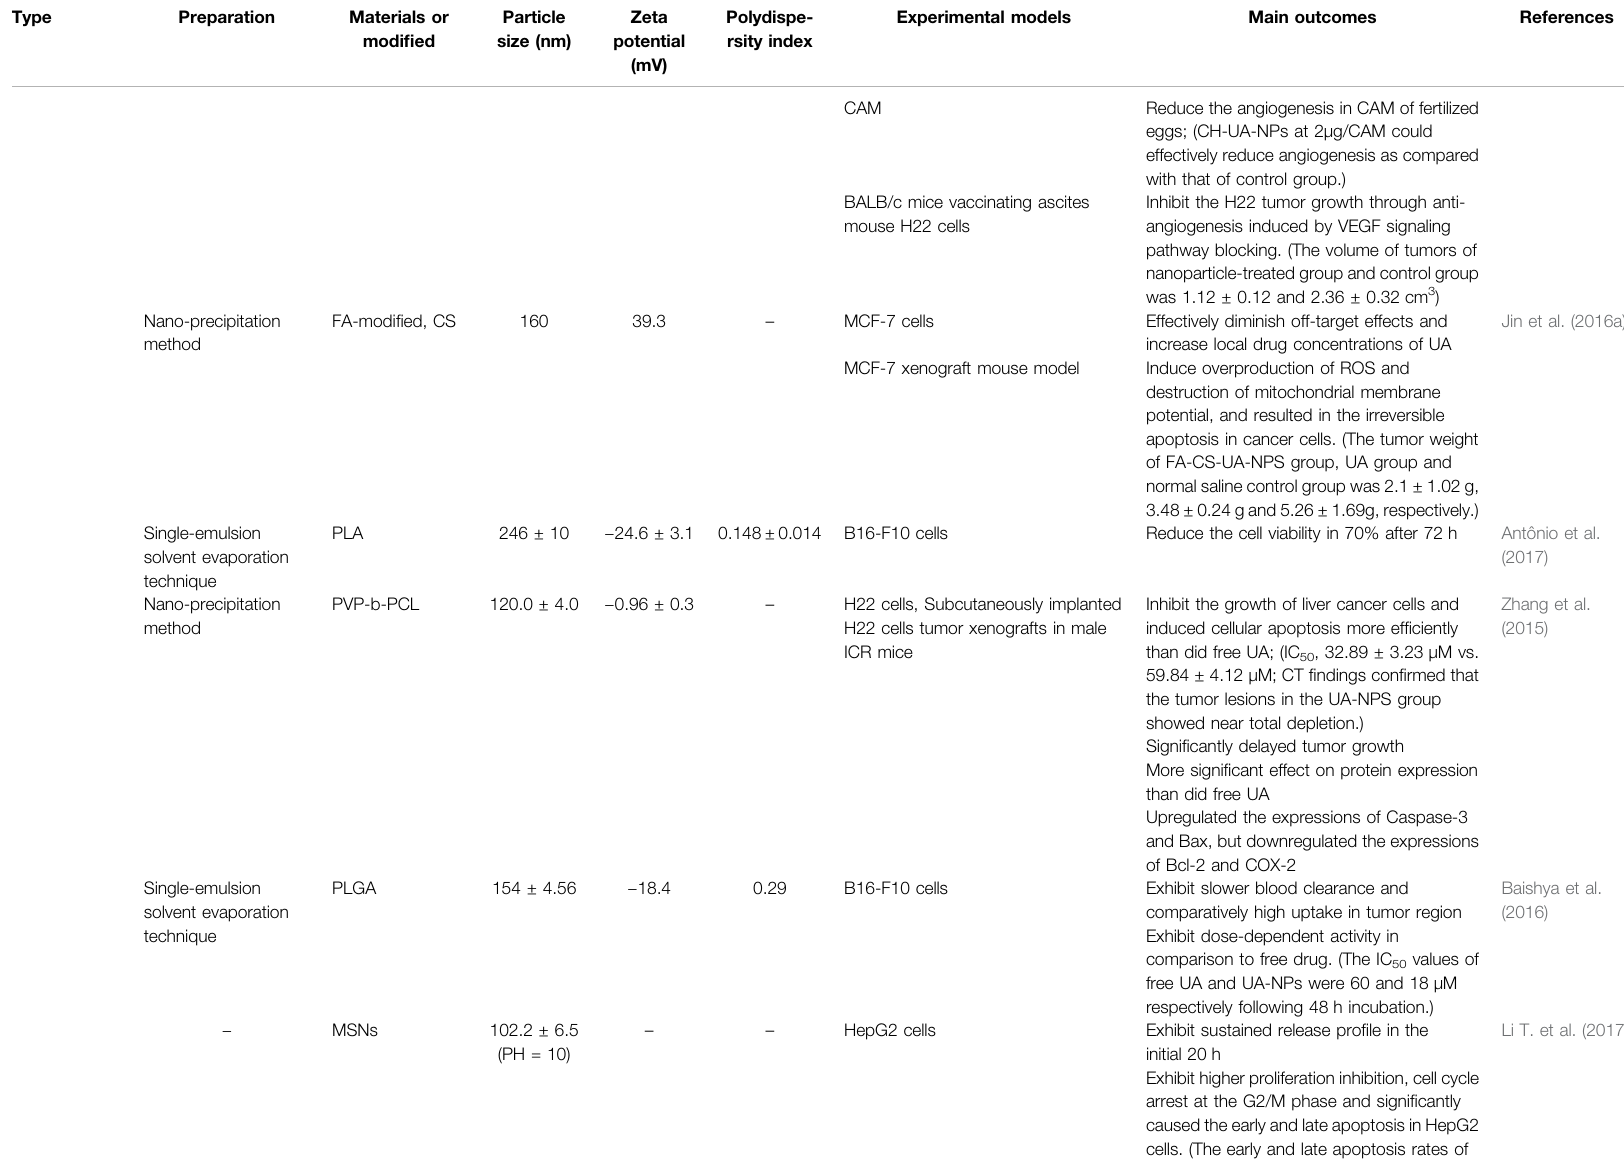
TABLE 2 | ( Continued ) The preparation, characteristics, and results about the anti-cancer effects of UA